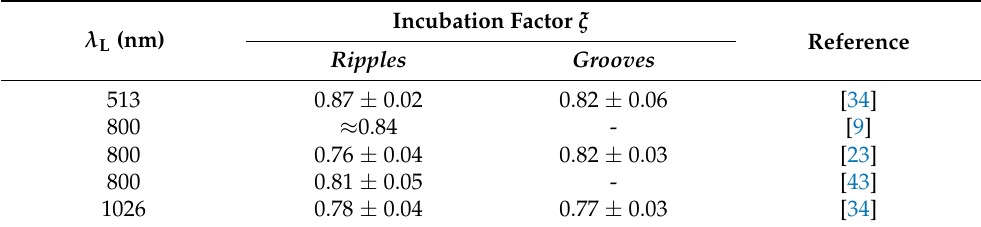
Table 1. Values of the incubation factor ξ registered for laser surface structuring of silicon at different laser wavelengths λ L both for ripples and